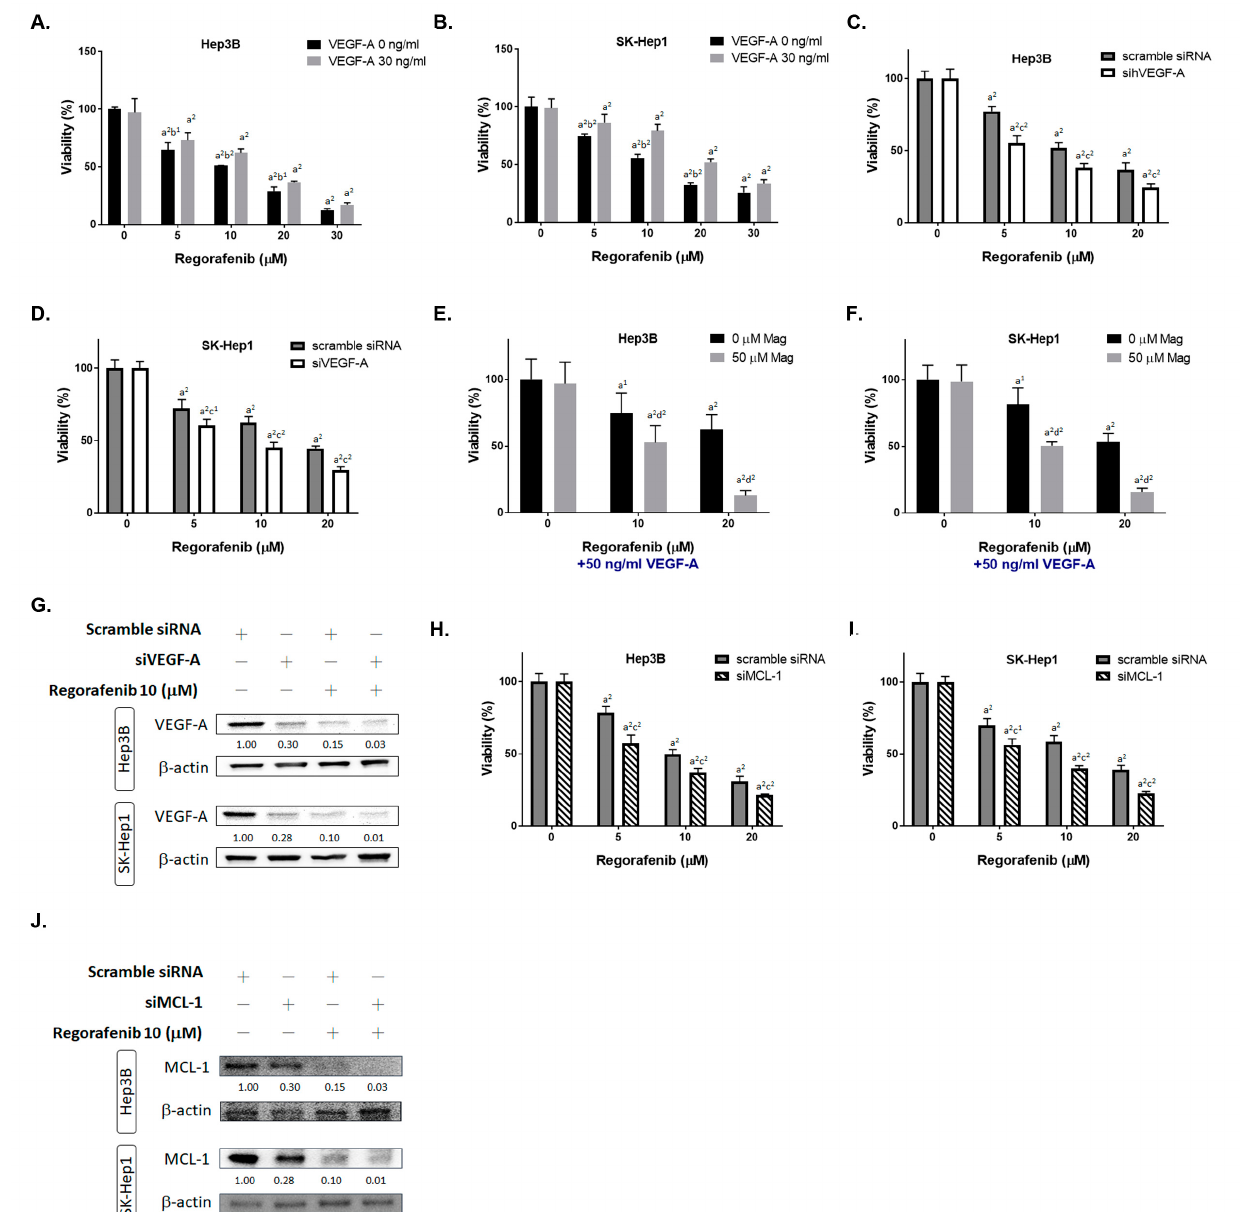
Figure 2. Inhibition of VEGF-A and MCL-1 may enhance the cytotoxicity of regorafenib. ( A ) Hep3B and ( B ) SK-Hep1 cells were treated with 0–20 µ M regorafenib combined with 30 ng/mL of VEGF-A recombinant protein (or not) for 48 h, and the cell viability was measured via the MTT assay. ( C ) The Hep3B and ( D ) SK-Hep1 cells were transfected with siVEGF-A combined with 0–20 µ M regorafenib (or not) for 48 h, and the cell viability was determined via the MTT assay. ( E ) The Hep3B and ( F ) SK-Hep1 cells were treated with 0–20 µ M regorafenib, 50 ng/mL of VEGF-A recombinant protein, and 50 µ M magnolol for 48 h, and the cell viability was determined via the MTT assay. ( G ) The VEGF-A Western blotting results in Hep3B and SK-Hep1 cells after being transfected with siVEGF-A combined with 0–20 µ M regorafenib (or not) for 48 h. ( H ) The Hep3B and ( I ) SK-Hep1 cells were transfected with siMCL-1 combined with 0–20 µ M regorafenib (or not) for 48 h, and the cell viability was determined via the MTT assay. ( J ) The MCL-1 Western blotting results in Hep3B and SK-Hep1 cells after transfection with siMCL-1 combined with 0–20 µ M regorafenib (or not) for 48 h. (a 1 p < 0.05 and a 2 p < 0.01 vs. 0 µ M regorafenib; b 1 p < 0.05 and b 2 p < 0.01 vs. 30 ng/mL VEGF-A; c 1 p < 0.05 and c 2 p < 0.01 vs. scramble siRNA; d 2 p < 0.01 vs. 0 µ M